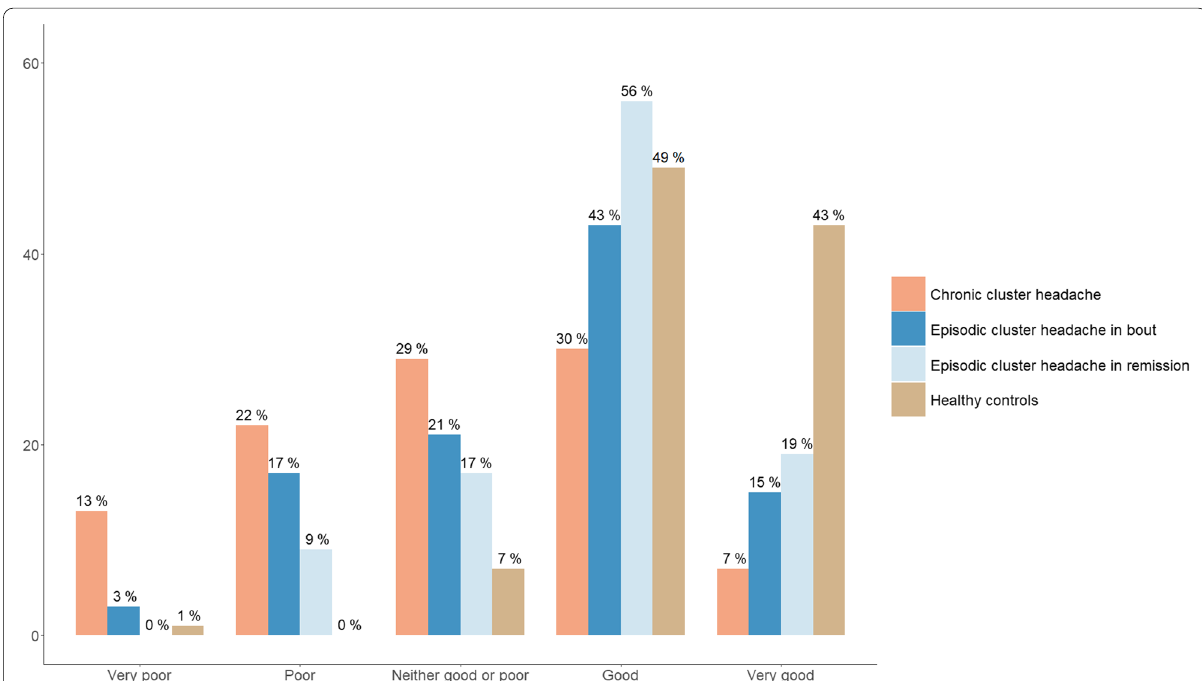
Fig. 2 Self-rated health among patients with cluster headache and controls. Legend: Patients and controls were asked to rate their current health ( N 599). Patients in bout were defined as having a cluster headache attack within the last month. We dichotomized participants responding = poor or very poor as poor and good or very good as good to increase power in an ordinal logistic regression adjusted for occupation and gender. Chronic cluster headache was the reference. Episodic cluster headache in bout were statistically indifferent to the chronic patients (OR 1.57, 95%CI 0.96–2.57, p 0.074), The episodic cluster headache in remission were statistically different from the chronic patients (OR 3.22, 95%CI 1.90–5.47, = p < 0.001), as were the controls (OR 10.10, 95%CI 5.29–18.79. p <